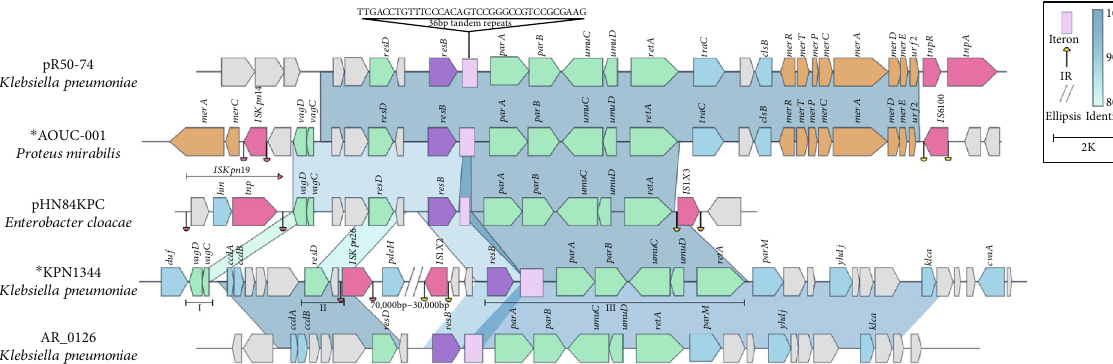
Figure 2: Linear comparison of the backbone regions of pR50-74, AOUC-001, PHN84KPC, KPN1344, and AR_0126. Genes are denoted by arrows. Genes, mobile elements, and other features are colored based on functional classi fi cation. The colors of the shadow areas represent di ff erent identities (80%-100%). Numbers under double diagonal indicate nucleotide positions for corresponding plasmids. Chromosome sequences are marked with